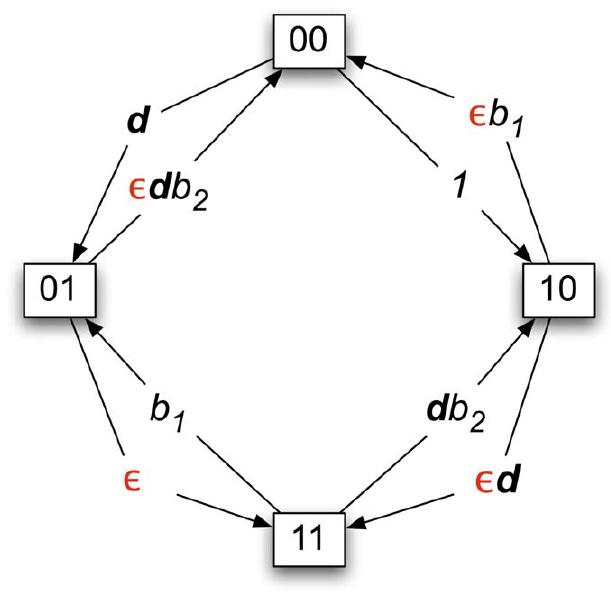
Figure 4. Disequon Model